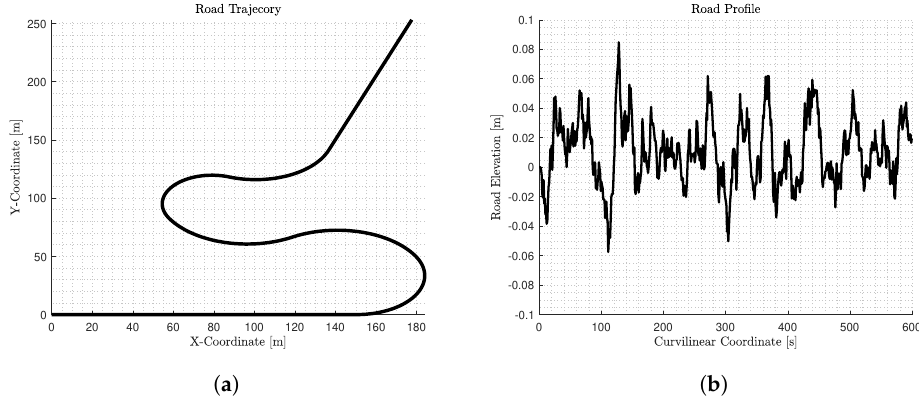
Figure 2. ( a ) The road path with the above X-Y trajectory and; ( b ) the Class B Road profile [24] assigned to